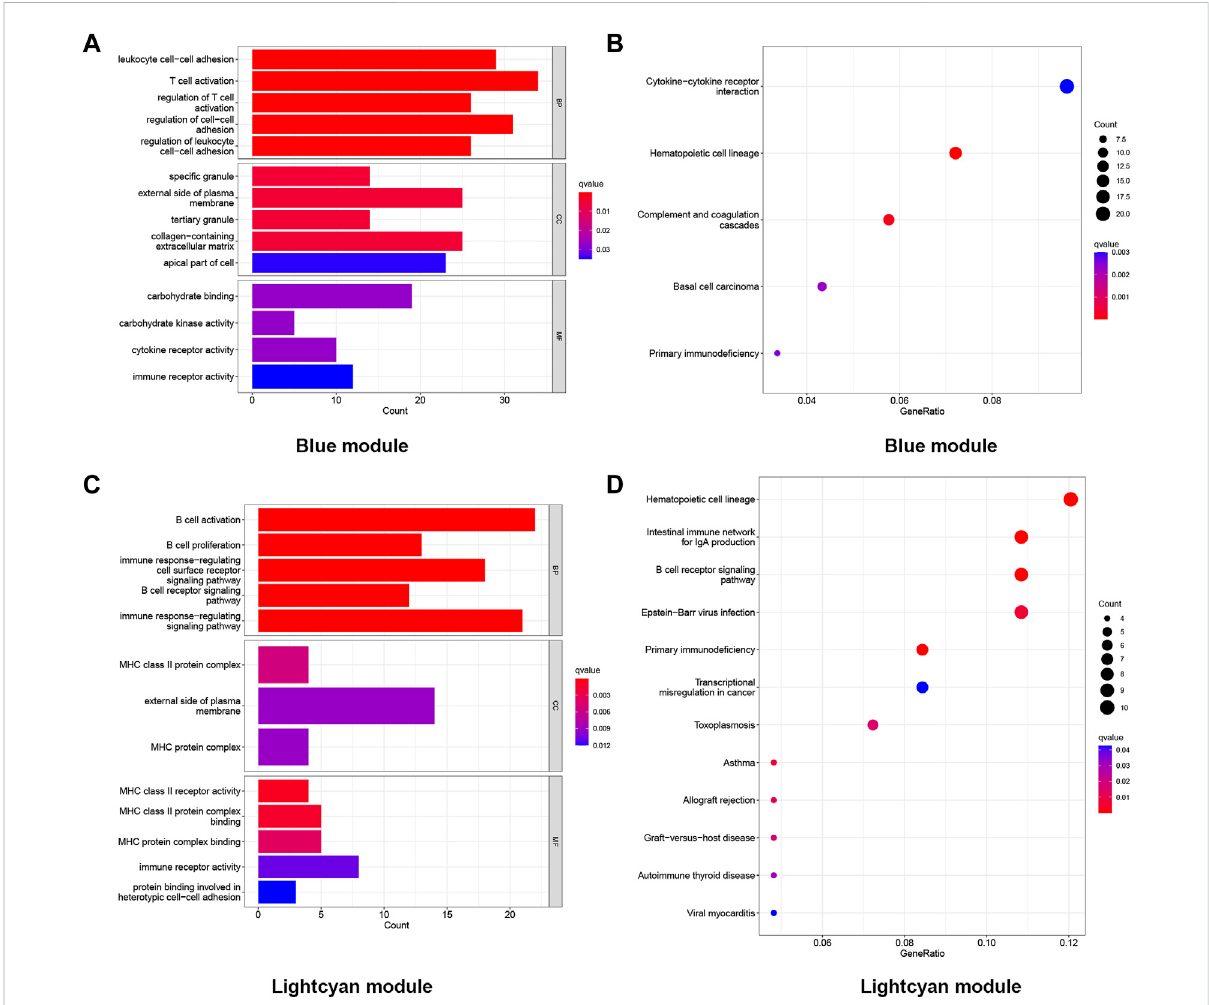
FIGURE 4 Functional enrichment analysis of the genes in the blue and light cyan modules. (A) GO enrichment analysis of genes in the blue module. (B) KEGG enriched the regulatory pathways of genes in the blue module. (C) GO enrichment analysis of genes in the light cyan module. (D) KEGG enriched theregulatory pathways of genesin thelightcyan module. Generatio, theproportion ofgenes enriched in thistermamongall genes